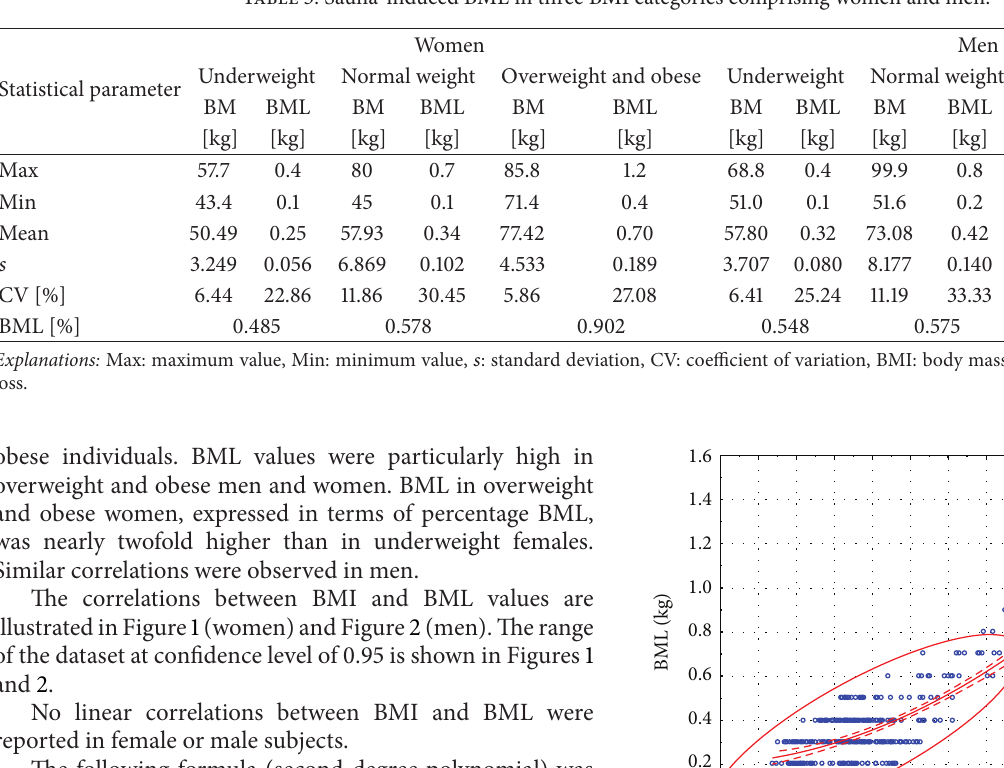
Table 3: Sauna-induced BML in three BMI categories comprising women and men.